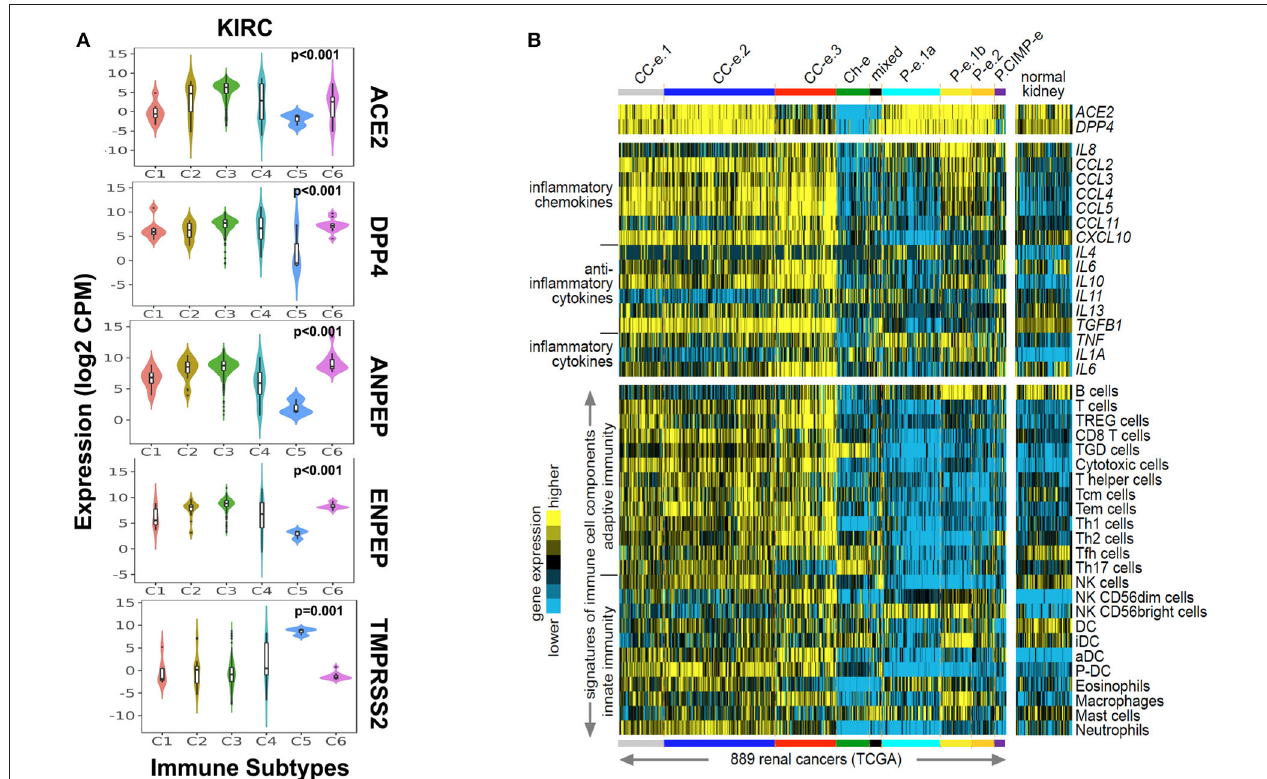
FIGURE 3 | Immune signatures in renal carcinoma with coronavirus receptors expression. (A) Violin plot for coronavirus receptors expression across various immune subtypes in KIRC tumors ( n = 515). TMPRSS2 exhibited the lowest expression as compared to other coronavirus receptors in C1–C4 and C6 immune subtypes. (B) Heatmaps of differential expression across renal cell carcinoma cases from TCGA dataset ( Chen et al., 2016) for genes encoding ACE2 and DPP4 (top), genes encoding selected chemokines and cytokines (middle), and gene expression-based signatures of immune cell infiltrates (bottom). Cases are ordered by